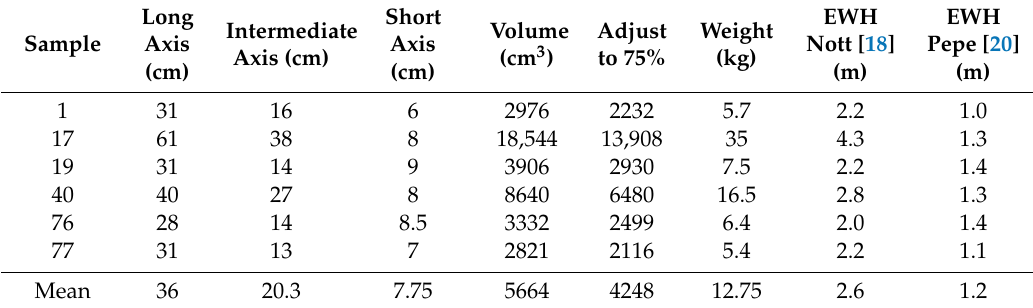
Table A3. Quantification of boulder size, volume, and estimated weight from selected coastal bar samples through transect 3 at Bah í a San Luis Gonzaga. EWH = estimated wave height. The density of Baja Californian andesite at 2.3 gm / cm 2 is applied uniformly in order to calculate wave height for each